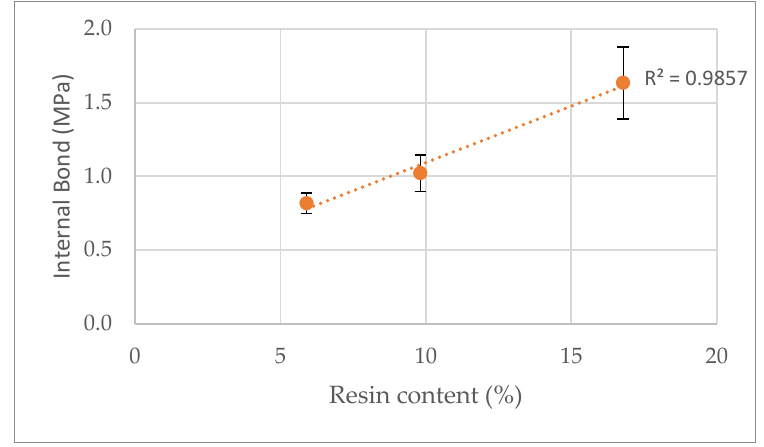
Figure 7. Correlation between internal bond variation and resin content.